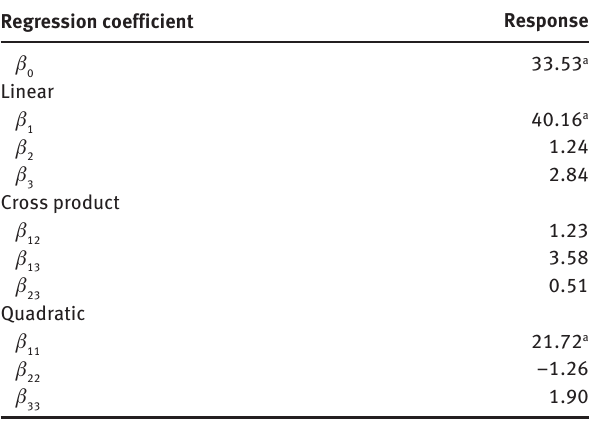
Table 3: Estimated coefficients of the fitted second-order polynomial model for AgNPs size.